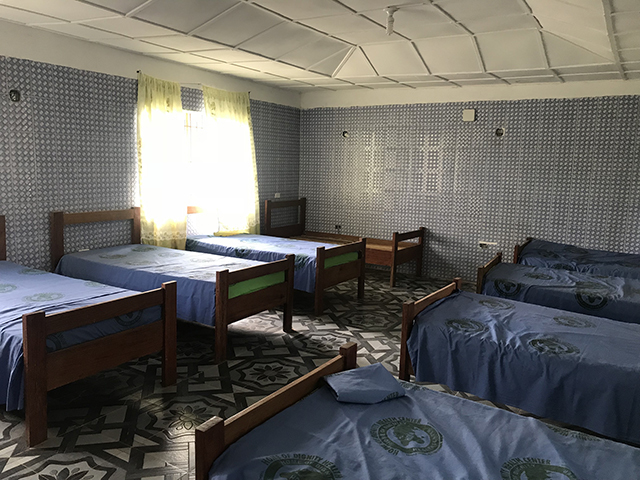
Patient care room.